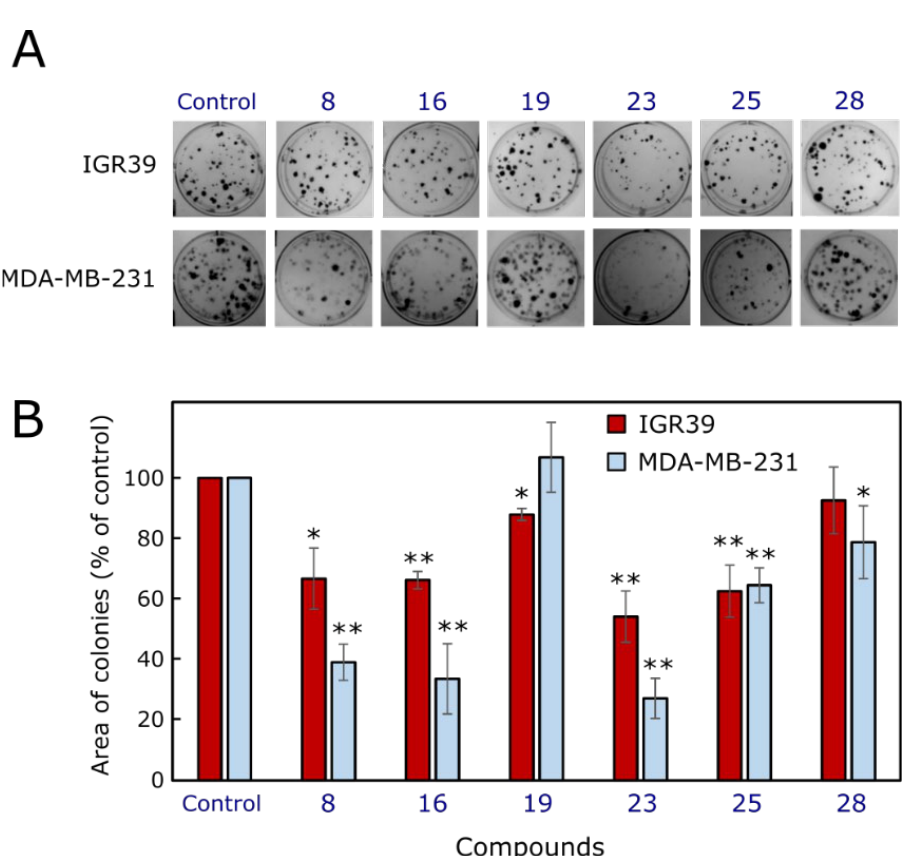
Figure 4. Effect of compounds on cell colony formation. ( A ) Photos of human melanoma IGR39 and human triple-negative breast cancer MDA-MB-231 colonies at the end of experiment. ( B ) Area of colonies at the end of experiment. Asterisks (*) indicate p < 0.05 and (**) indicate p < 0.01 compared to the control (untreated cells). Experiments were repeated three times, calculating the mean and standard